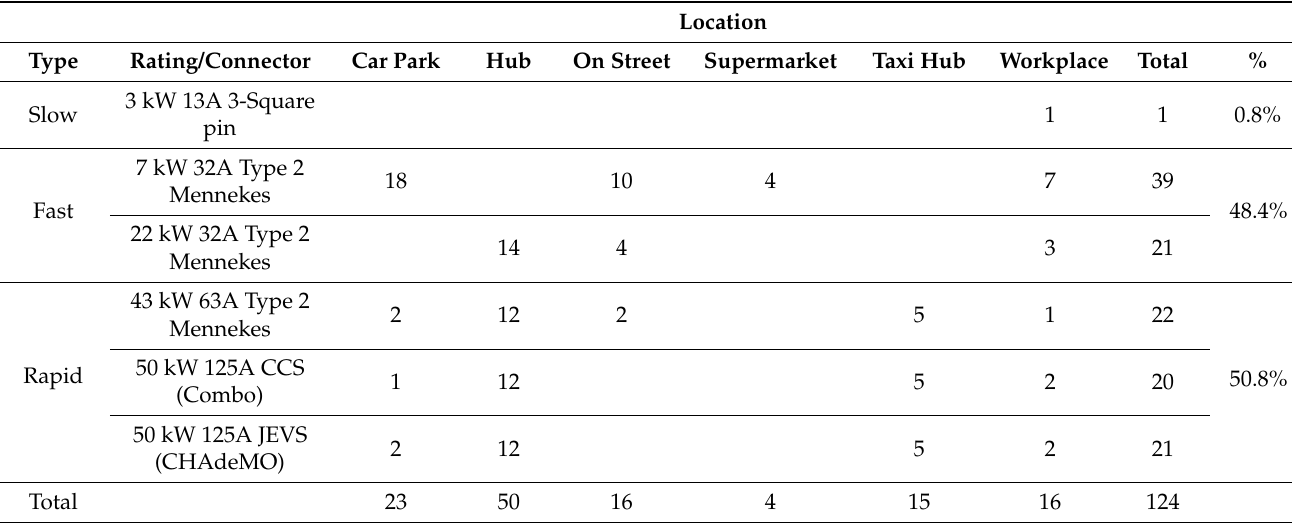
Table 1. List of charge points in Dundee categorised by location and type.